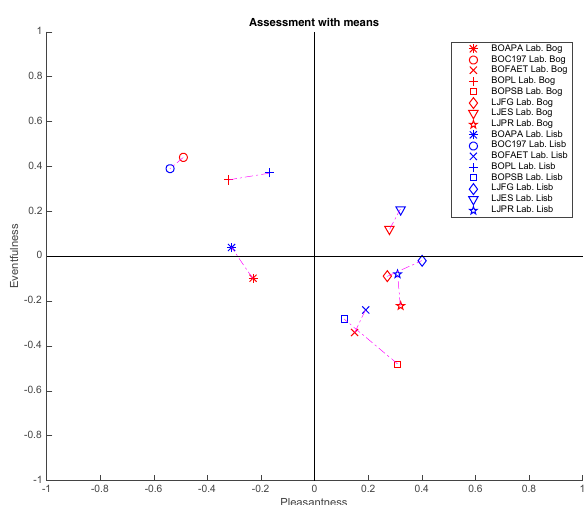
Figure 5. Application of Axelsson’s two-dimensional model. In red, places evaluated in Bogotá-Colombia. In blue, places evaluated in Lisbon-Portugal.